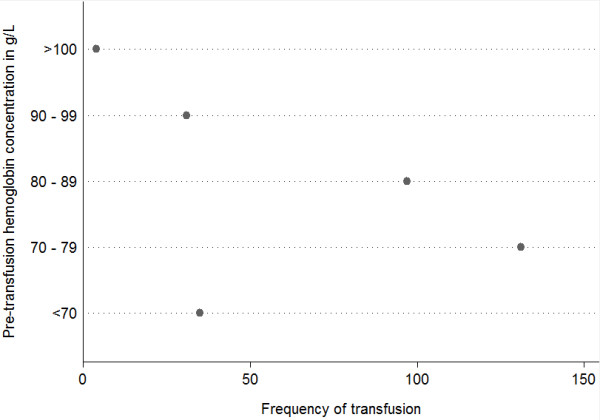
Frequency of transfusions in each patient group according to pre-transfusion hemoglobin concentration.